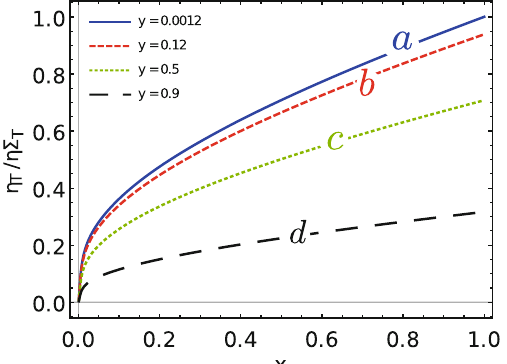
as function of x T